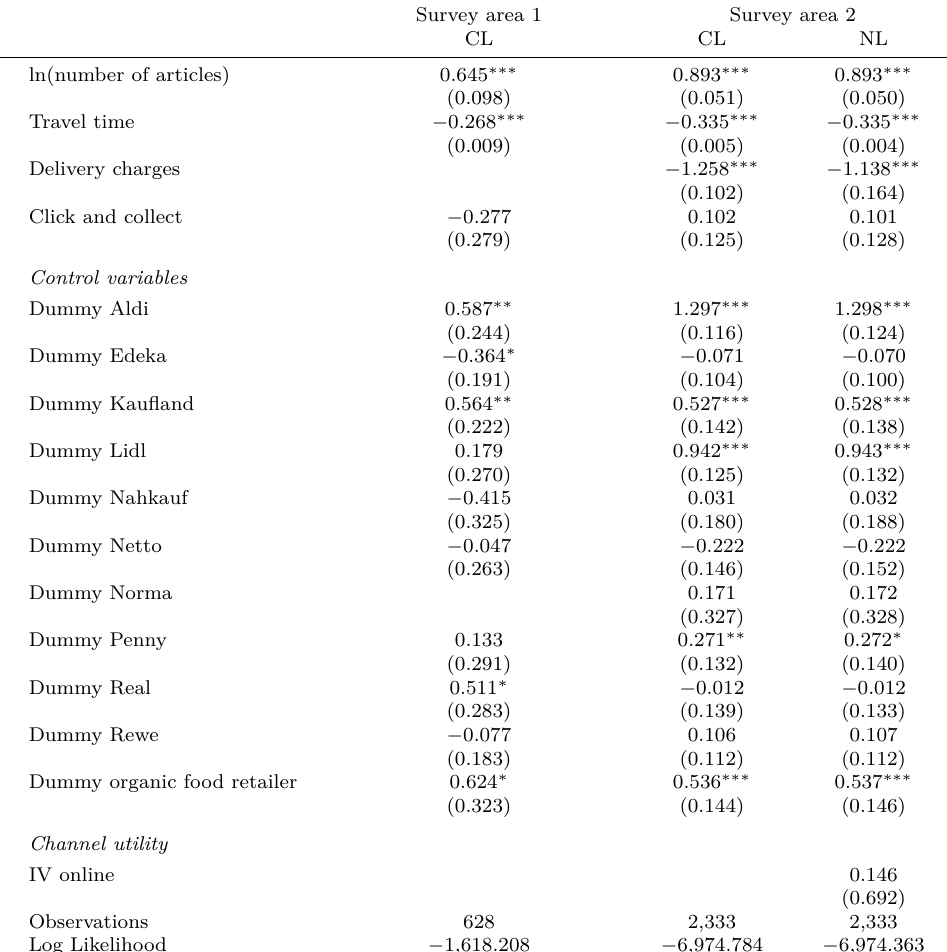
Table 7: Discrete Choice analysis for grocery stores by survey area – Dependent variable: Store choice